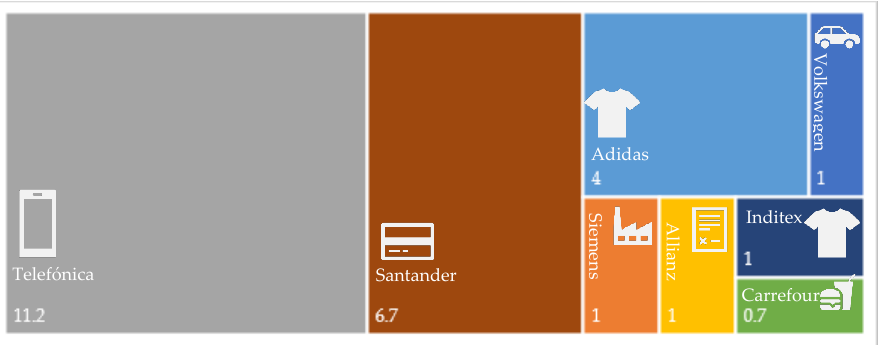
Figure 3. Examples of private investment in Industry 4.0 (annually —€ billion).